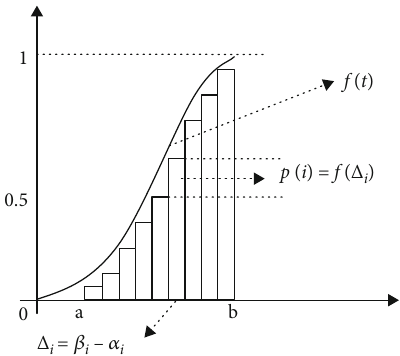
Figure 1: Discretization of empirical distribution of time